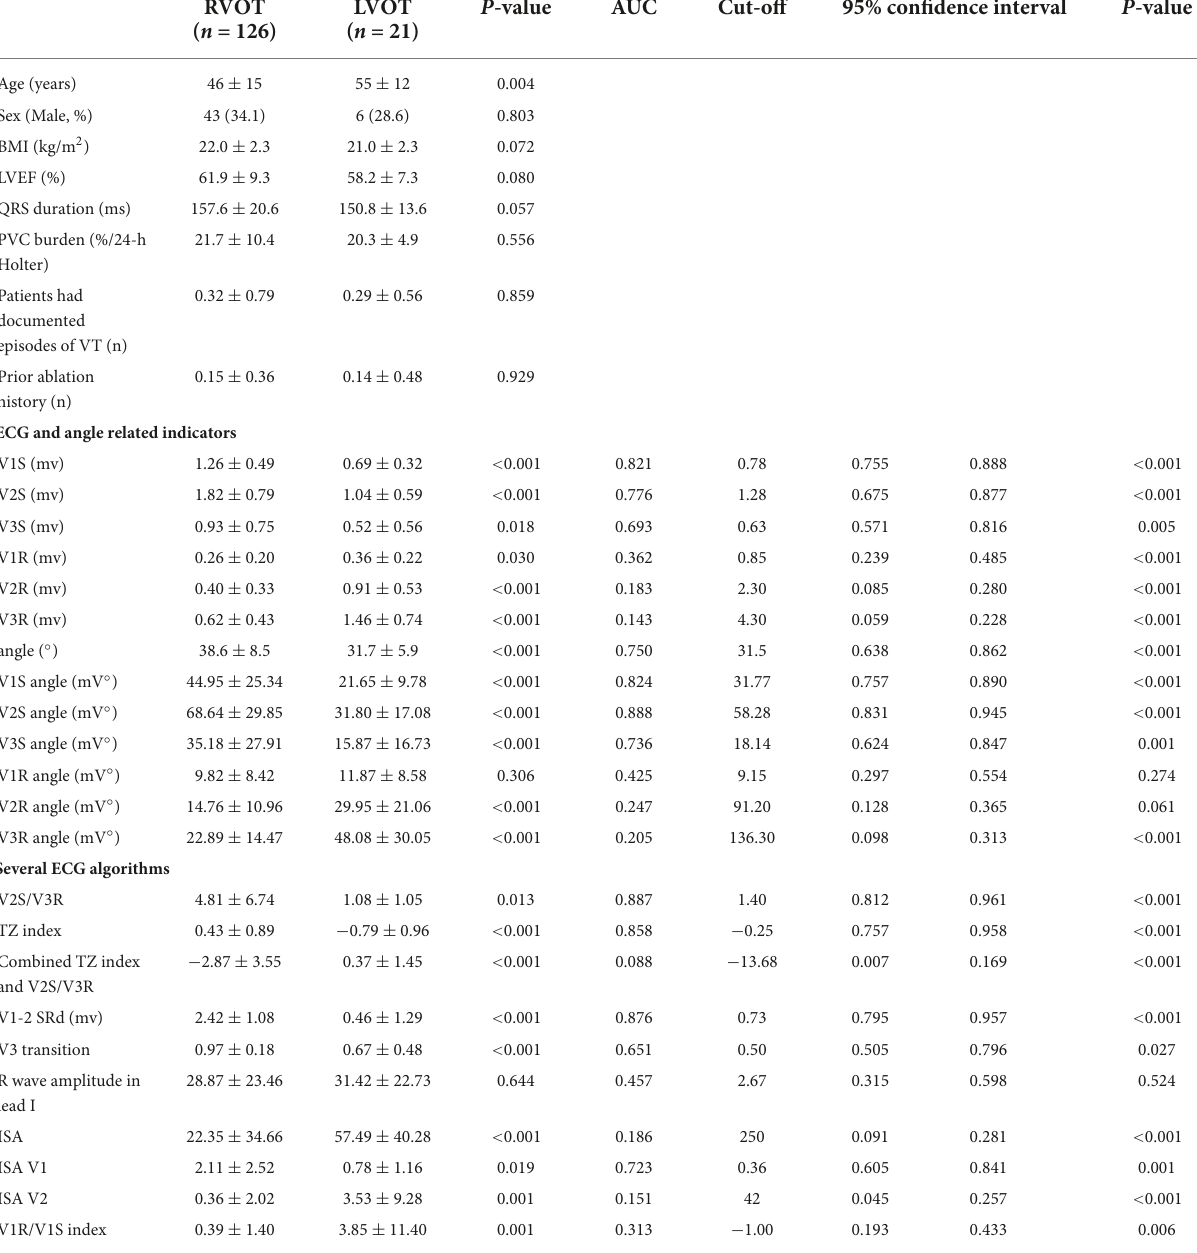
TABLE 2 Baseline patient characteristics and electrocardiographic characteristics of the retrospective cohort ( n = 147). P -value AUC RVOT LVOT ( n = 126) ( n = 21)